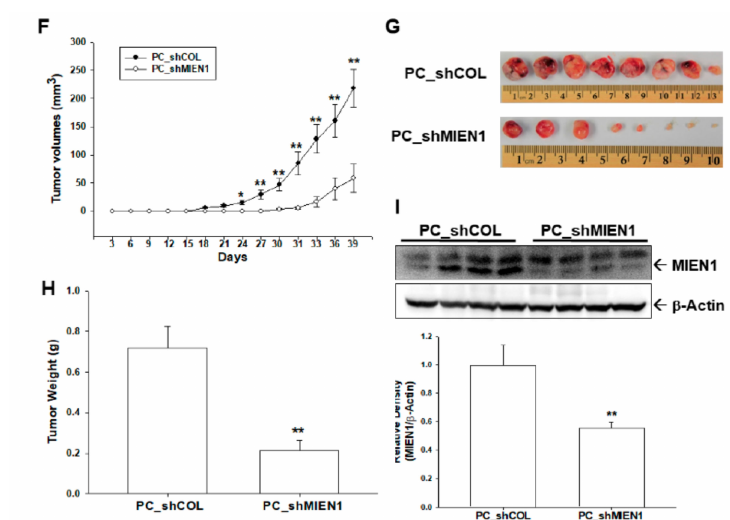
Figure3. E ff ectsofmigrationandinvasionenhancer1(MIEN1)oncellproliferationandtumorigenesisin